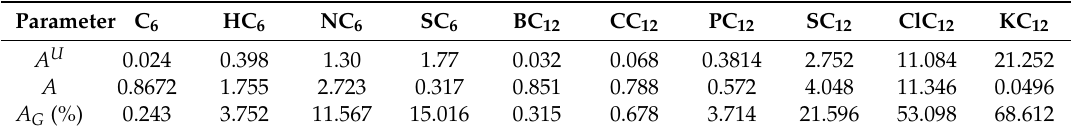
Table 2. Universal elastic anisotropy index ( A U ), Zener anisotropy index ( A ), and percentage anisotropy in shear ( A G